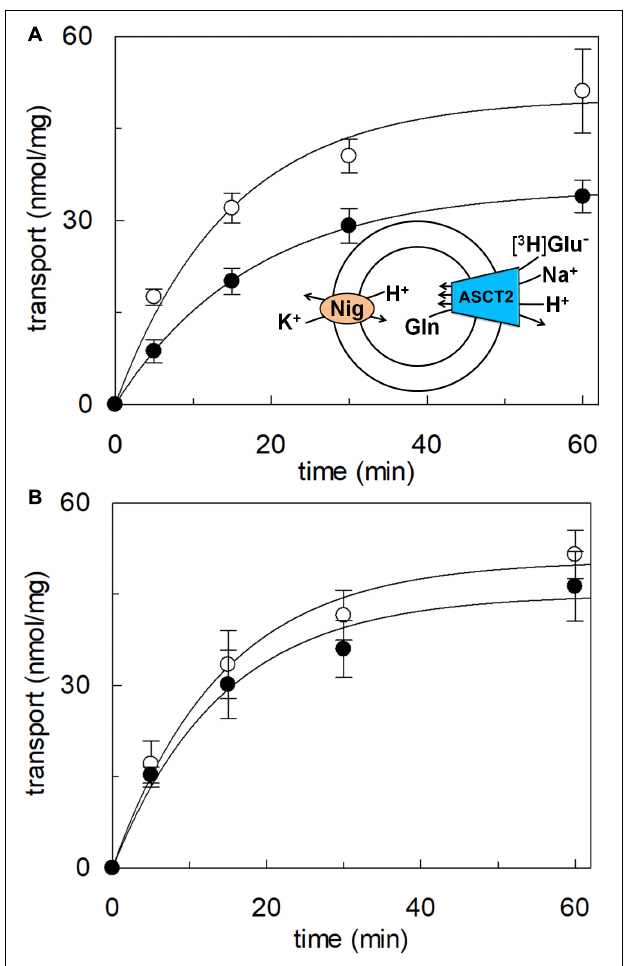
FIGURE 7 | Effect of imposed membrane proton gradient on glutamate transport by hASCT2 reconstituted in proteoliposomes. Purified hASCT2 was reconstituted in proteoliposomes as described in materials and methods. After sephadex-G75 chromatography, proteoliposomes were treated with nigericin (0.12 µ g/mg phospholipid) ( ◦ ) to impose the artificial membrane proton gradient. The vehicle of nigericin, ethanol ( • ) was used as control of nigericin treatment. The transport assay was started adding 500 µ M of [ 3 H]glutamate together with 20 mM Na-gluconate and 30 mM K-gluconate to proteoliposomes containing 10 mM glutamine (A) . In (B) , the transport was performed in the absence of external K-gluconate, as control. In the figure, sketch of the experimental set up (proteoliposomes); Nig: nigericin. The transport was measured at the indicated times according to the stop inhibitor method. Data were plotted according to the first-order rate equation. Results are means ± SD from four independent experiments.